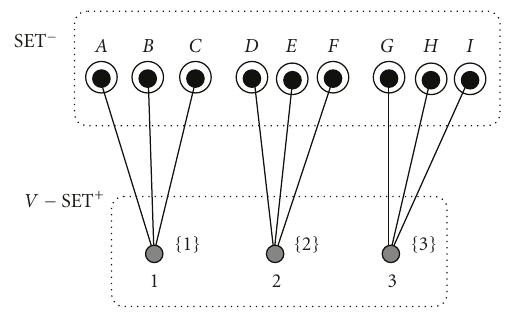
Figure 8: In the worst case, the complexity of finding COV is O ( n − | SET + | + | SET − | ). It processes one node in each